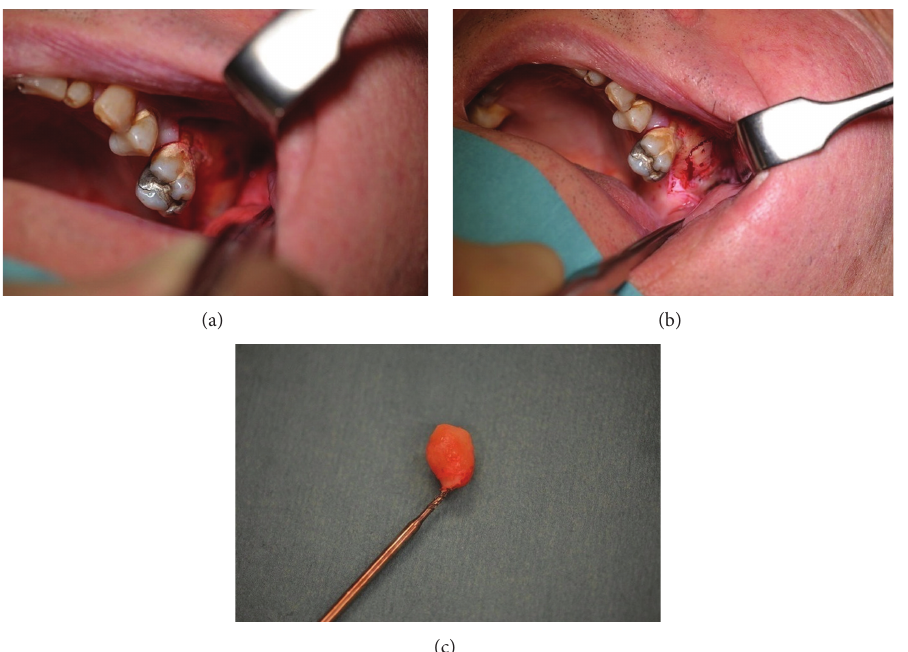
Figure 3: Vestibular incision extending to the left maxillary tuberosity (a), creation of a bony window in the anterior wall of the left maxillary sinus (b), and ectopic third molar showing complete crown but incomplete root formation